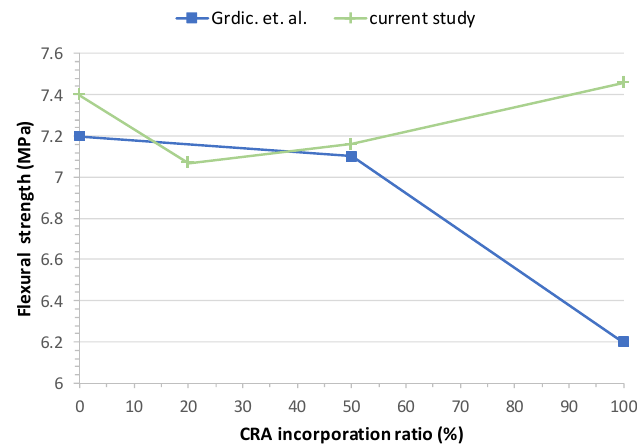
Figure 18. 28-day flexural strength test overview.